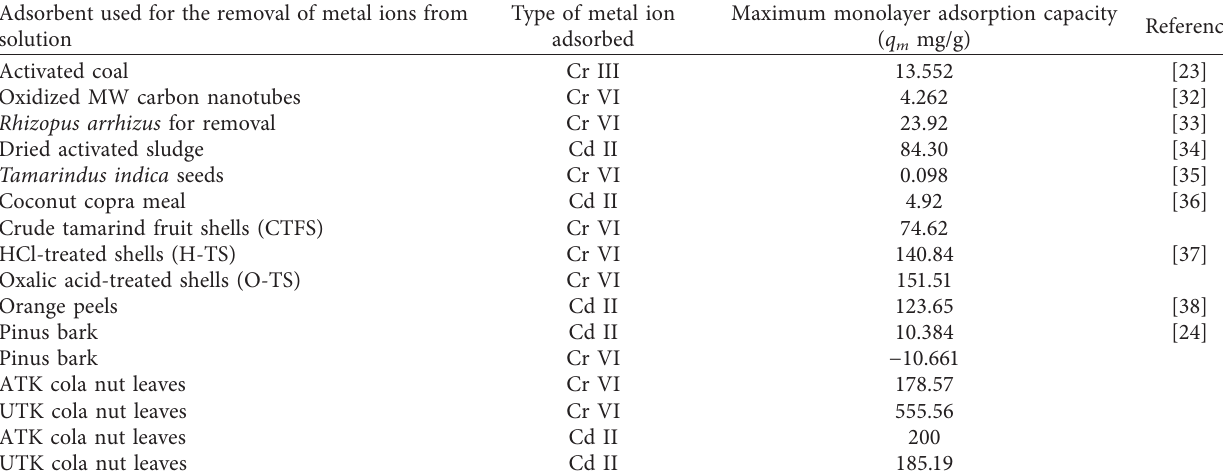
Table 4: q m of various adsorbents for the removal of Cd (II) and Cr (VI) ions. Adsorbent used for the removal of metal ions from solution